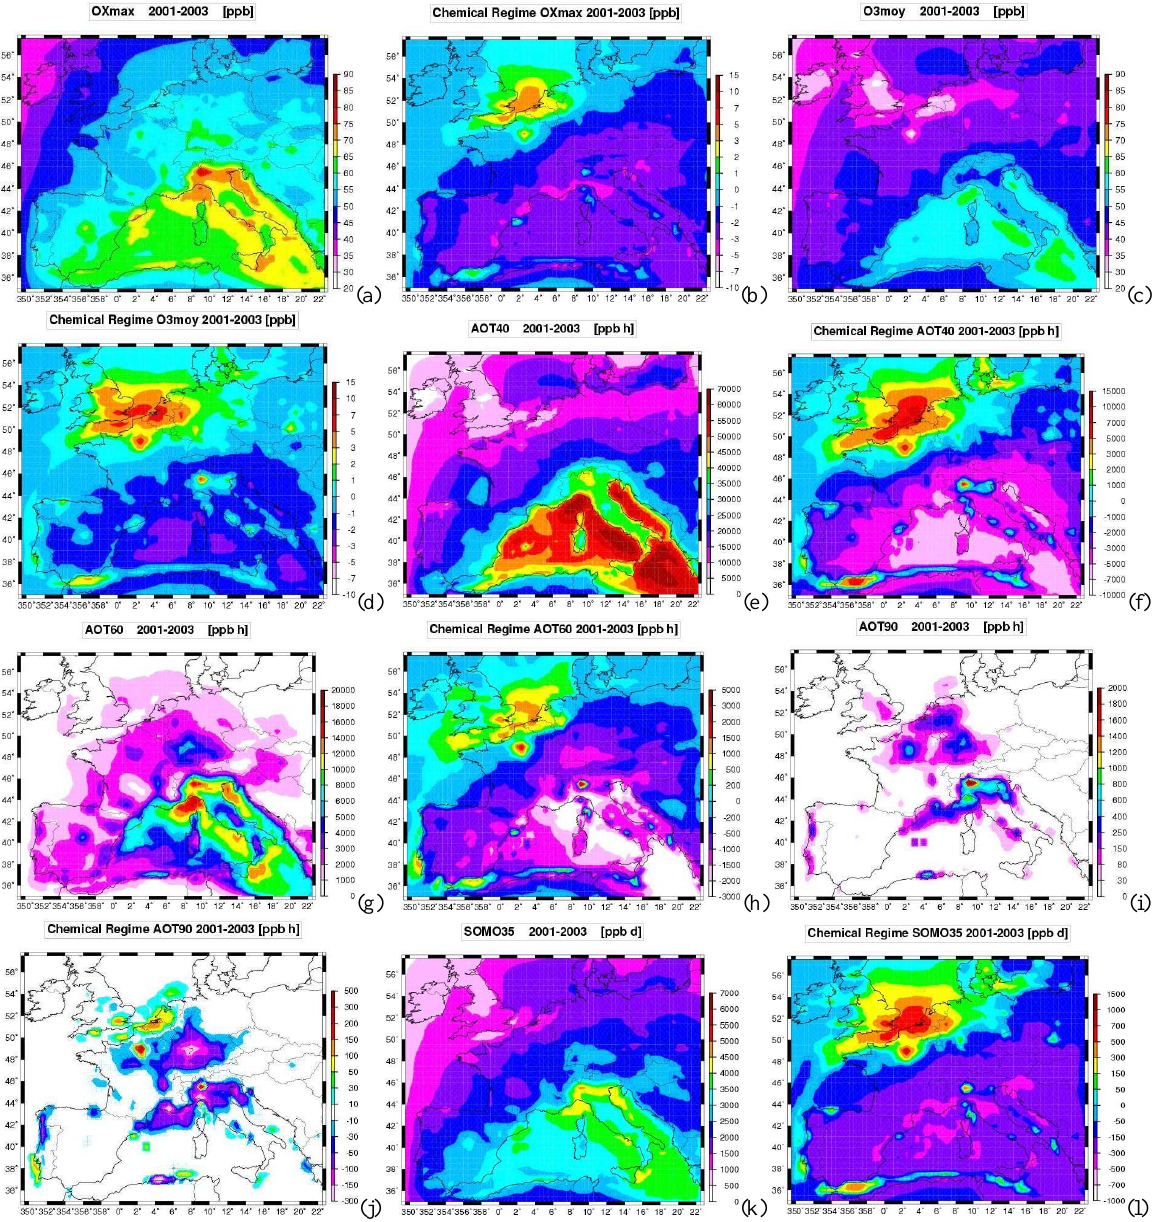
Fig. 2. Reference and chemical regime simulations for different ozone targets (period as in Fig. 1): (a,b) daily O x (=O 3 +NO 2 ) maximum, (c,d) daily mean ozone, (e,f) AOT40, (g,h) AOT60, (i,j) AOT90, (k,l) SOMO35; for definition of AOT’s and SOMO35 see explanation in the